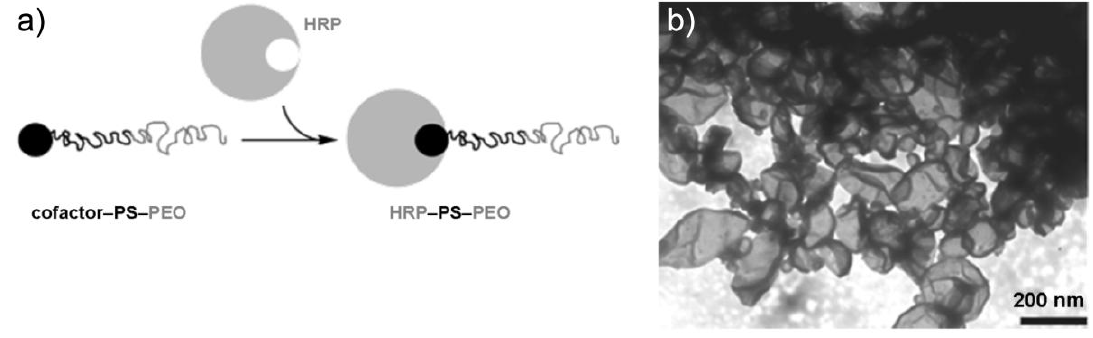
Figure 13. ( a ) Schematic representation of the formation of giant amphiphiles with an enzyme head group by cofactor reconstitution. ( b ) Transmission electron micrograph of PEG- b -PS- b -HRP vesicles. Reproduced by permission of the American Chemical Society